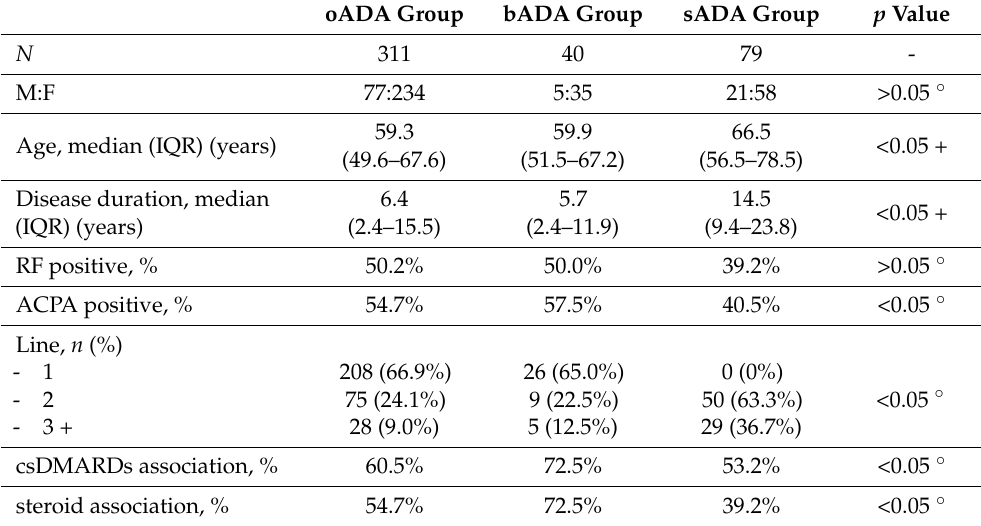
Table 2. RA cohort characteristics.